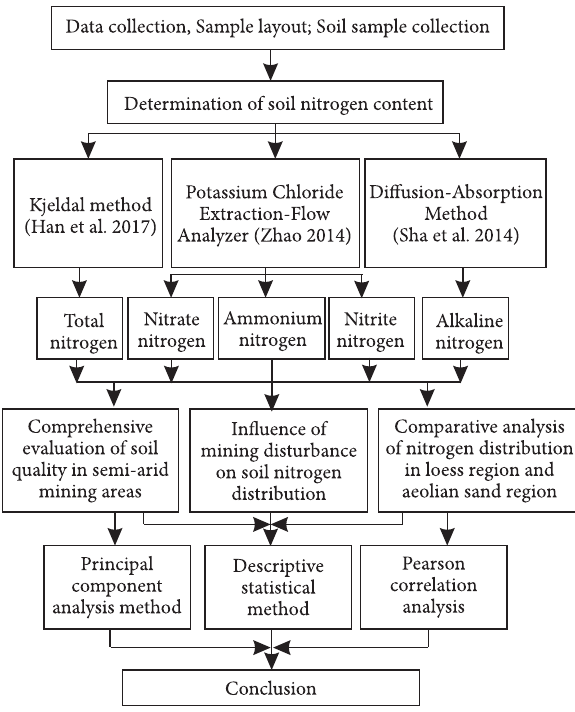
Figure 3. The flow chart of the methodology for this